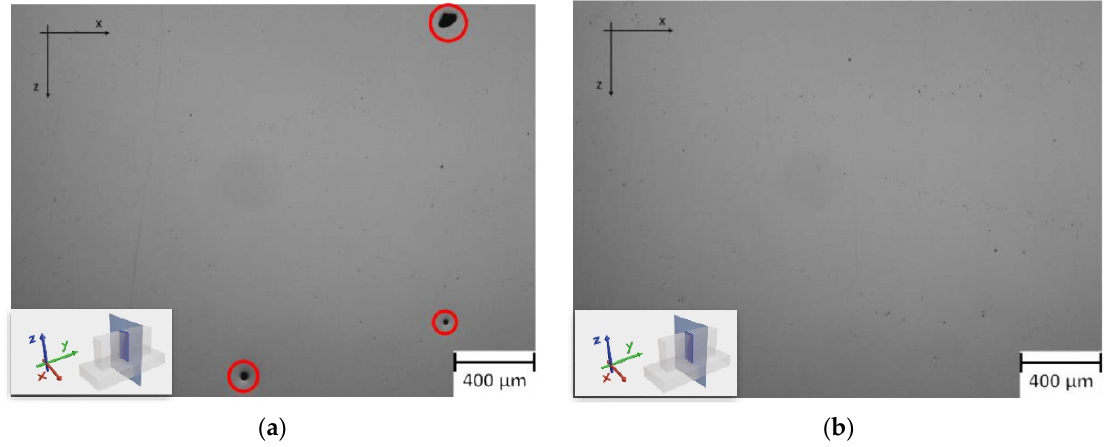
Figure 9. XZ surface porosity: ( a ) Near baseplate interface (pore zones in red) [17]; ( b ) Intermediate height (mechanical testing region) [17].